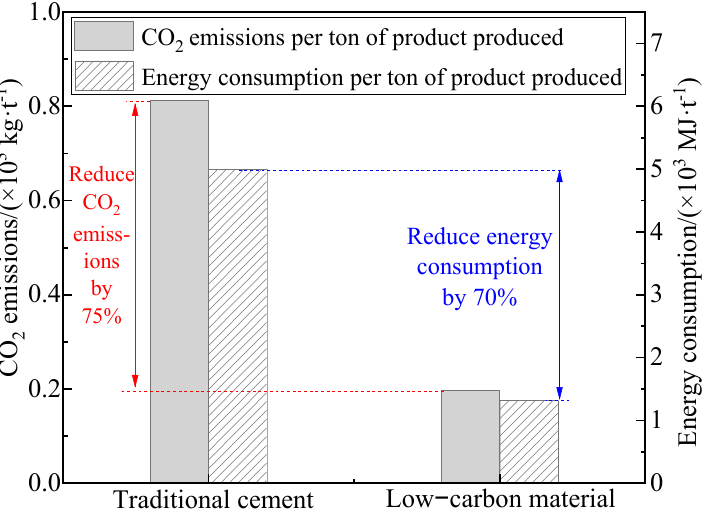
Figure 13. The comparison of CO 2 emissions and energy consumption between traditional cement and low-carbon material.